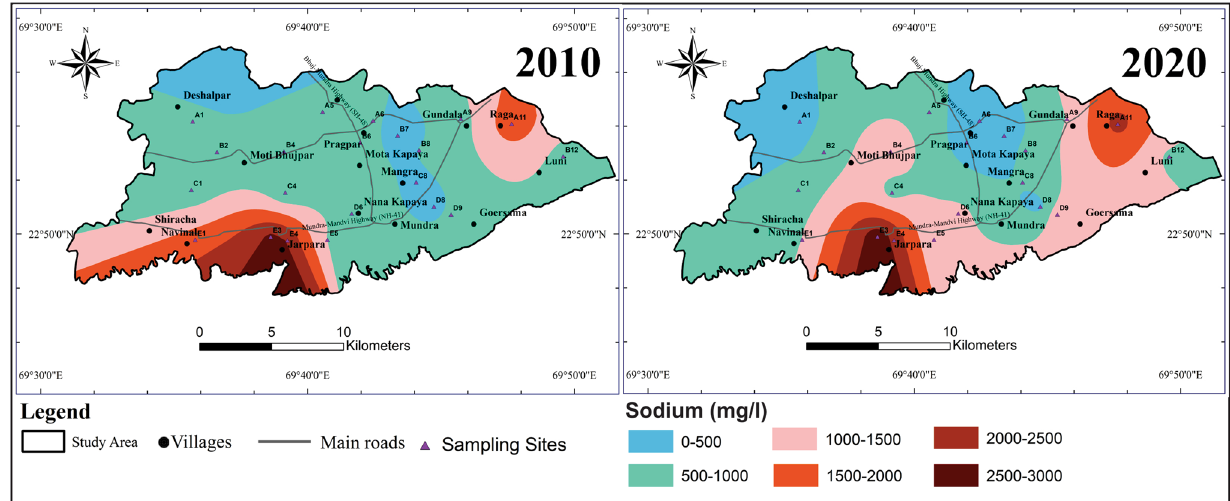
Fig. 4 Geospatial distribution of sodium (Mg/L) of 2010 (Bhimani 2013 and